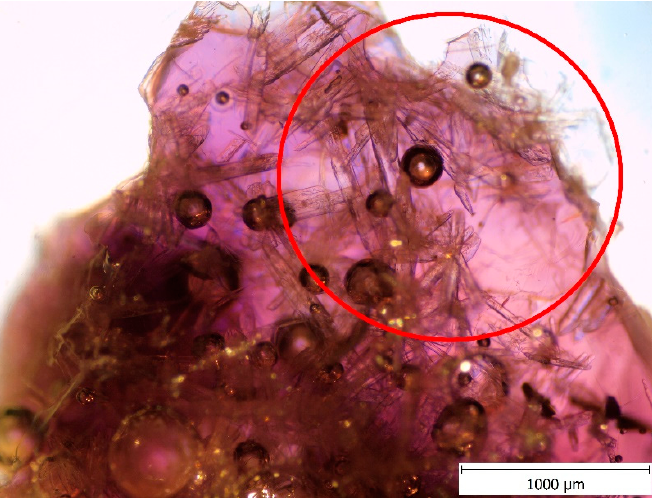
Figure 7. Wollastonite crystals in Renaissance model glass, OM.